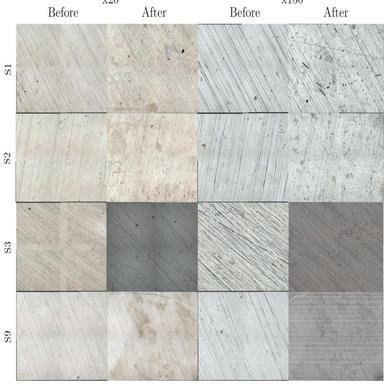
316 stainless steel sample (small sample), combined laser and optical images obtained by 3D profilometry before and after testing.